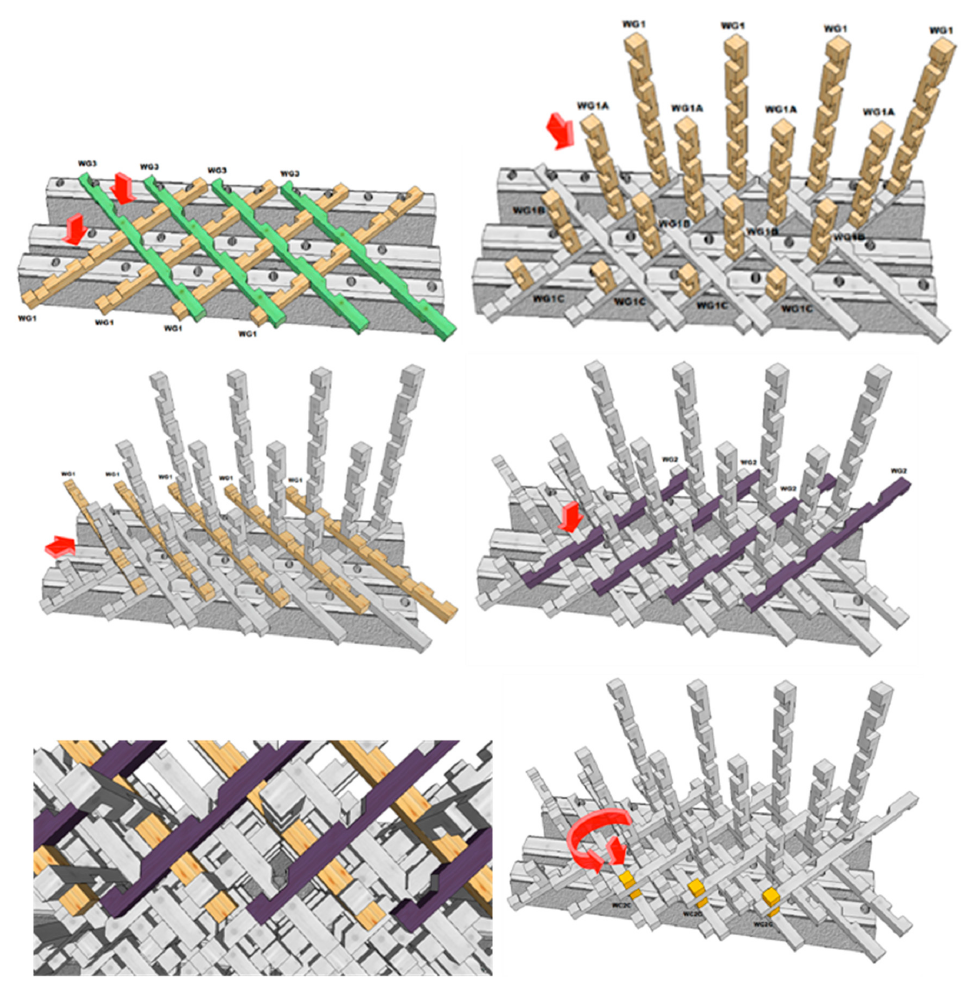
Figure 8. The assembly steps (the arrows indicate the movements of each component).